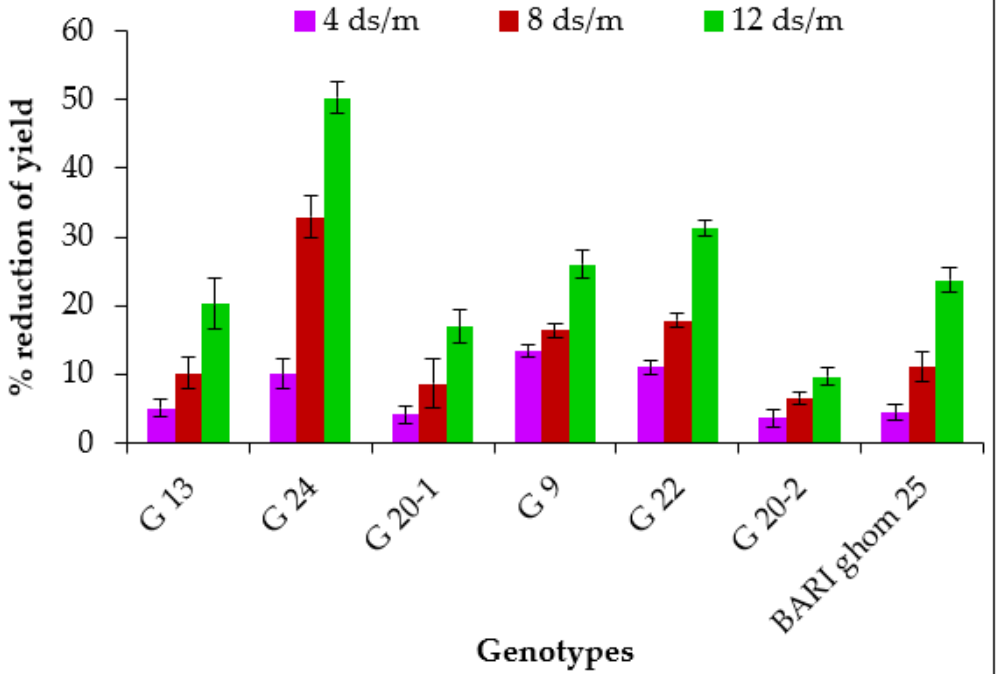
Figure 8. Reduction (%) of grain yield of wheat genotypes under various salinity levels. The vertical bar indicates average of five independent replicates ( n = 5). Error bars represent standard error.